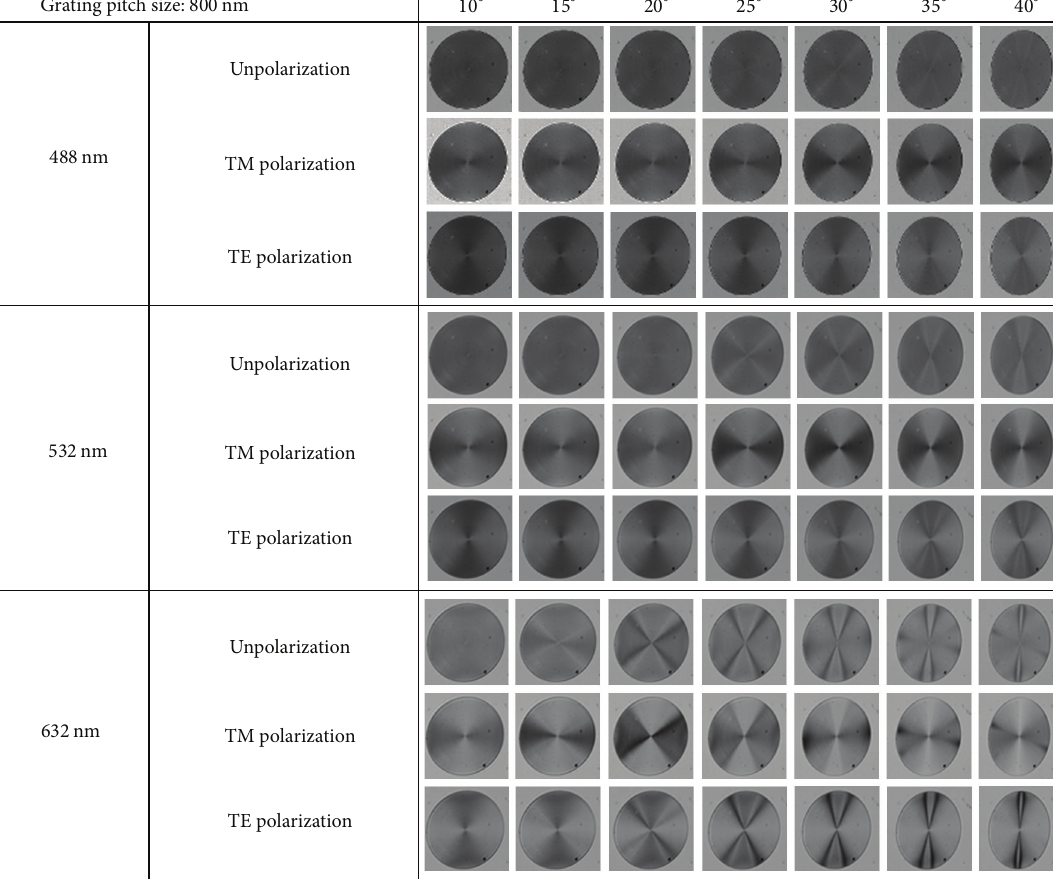
Figure 2: Measured reflected intensity images with various incident angles (ranging from 10 ∘ to 40 ∘ ) by CCD through TM-polarized, TE- polarized, and unpolarized incident light at three visible wavelengths of 488 nm, 532 nm, and 632 nm, respectively. The grating pitch size is 800